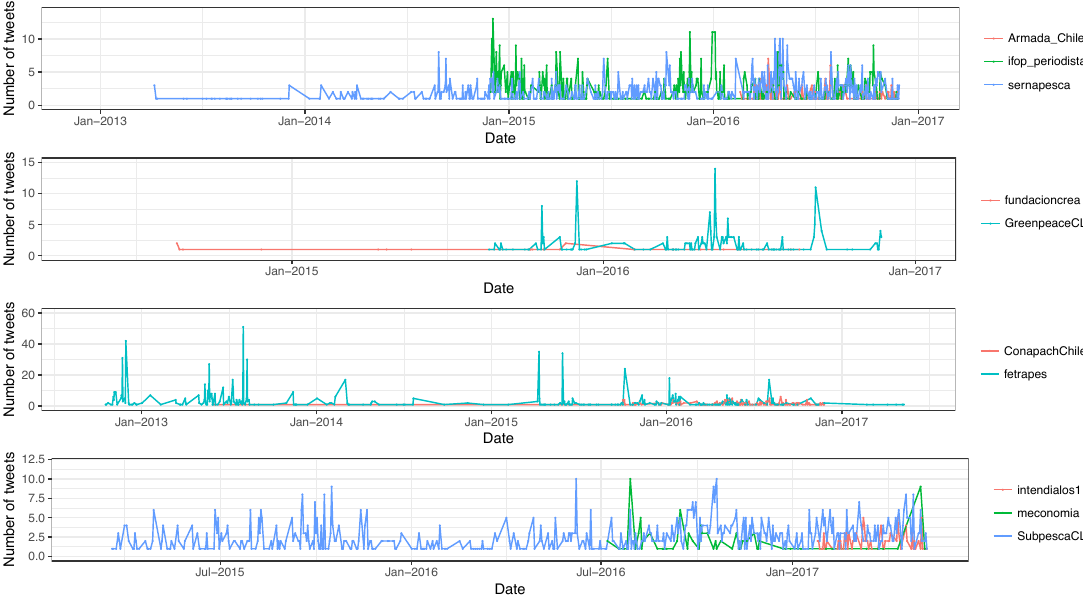
Figure A1.1 Time series of actors’ utterances 2013-2017